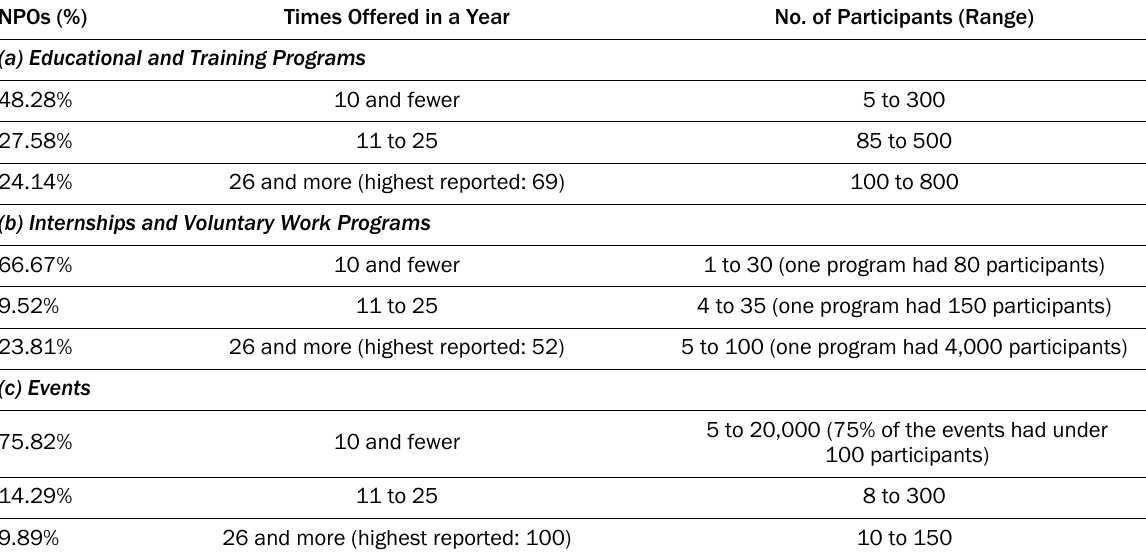
Table 1. Program and Event Participation by